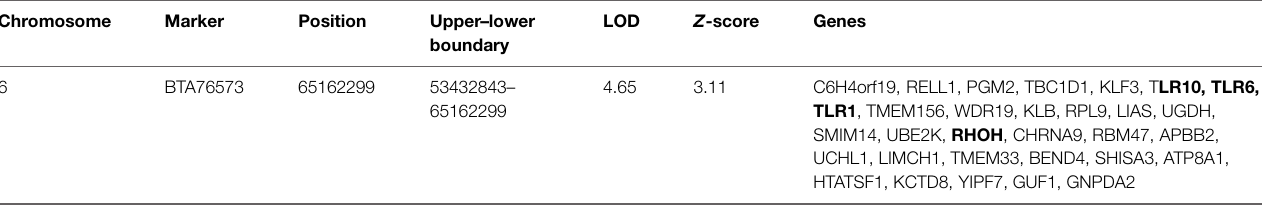
TABLE 2 | Genes in the one-LOD interval in chromosome 6 with significant LOD and Z -score values. Chromosome Marker